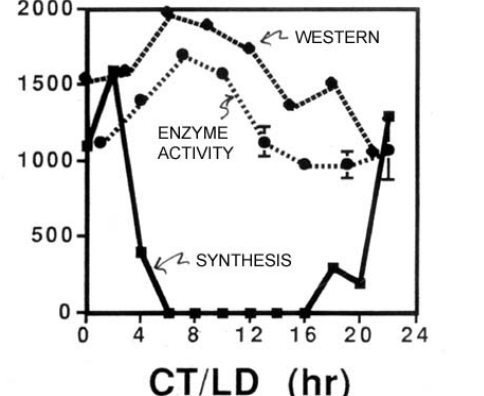
Figure 2. Measurements (ordinate) over time in constant conditions of the enzyme activity, abundance (Western blots) and synthesis rate of the enzyme glyceraldehyde dehydrogenase